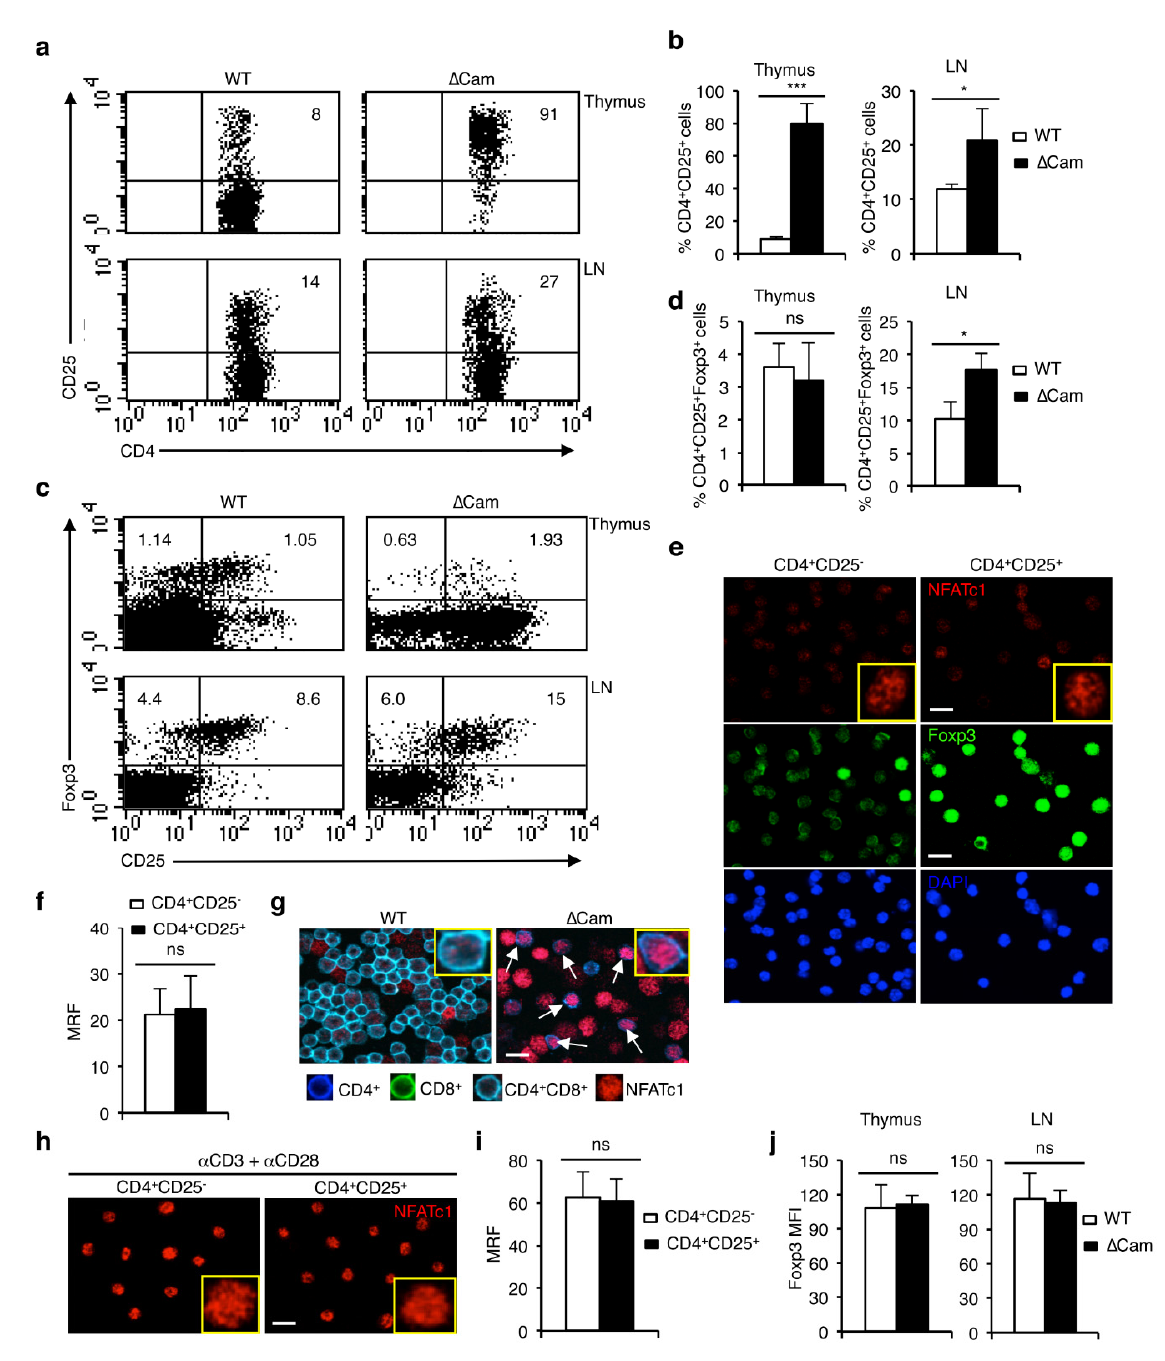
Figure 1. Constitutively active calcineurin/NFAT activity does not affect thymic development of Foxp3 + T reg cells. ( a ) Distribution of CD4 + CD25 + cells in the thymus and LNs from WT and ∆ Cam tg mice as revealed by flow cytometry. ( b ) Quantification of the frequency of CD4 + CD25 + cells in the thymus and LNs from WT and ∆ Cam tg mice (*** p < 0.0001 and * p = 0.0342; unpaired t -test). ( c ) Distribution of CD4 + CD25 + Foxp3 + cells in the thymus and LNs from WT and ∆ Cam tg mice as revealed by flow cytometry. ( d ) Quantification of the frequency of CD4 + CD25 + Foxp3 + cells in the thymus and LNs from WT and ∆ Cam tg mice (ns = not significant and * p = 0.0101; unpaired t -test). In ( b , d ), n = 5 each. Numbers inside each dot plot indicate percent respective populations. ( e ) Immunofluorescence